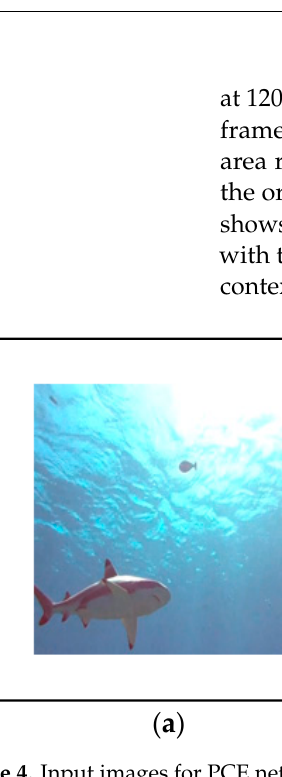
Figure 4. Input images for PCE network with central area as original content and white space shows the extended area (will be replaced with extended content) ( a ) 32 pixels band ( b ) 48 pixels band and ( c ) 64 pixels band.